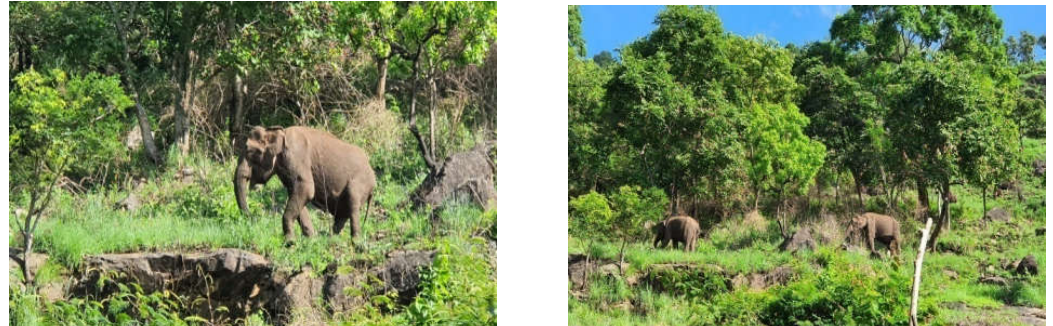
Figure 2. Direct feeding behaviour (grass fodder) of elephants in the study area . Proximate analysis: The grass fodder samples were collected from the forest and were cut into small pieces so as to facilitate easy handling and uniform sampling for anal-